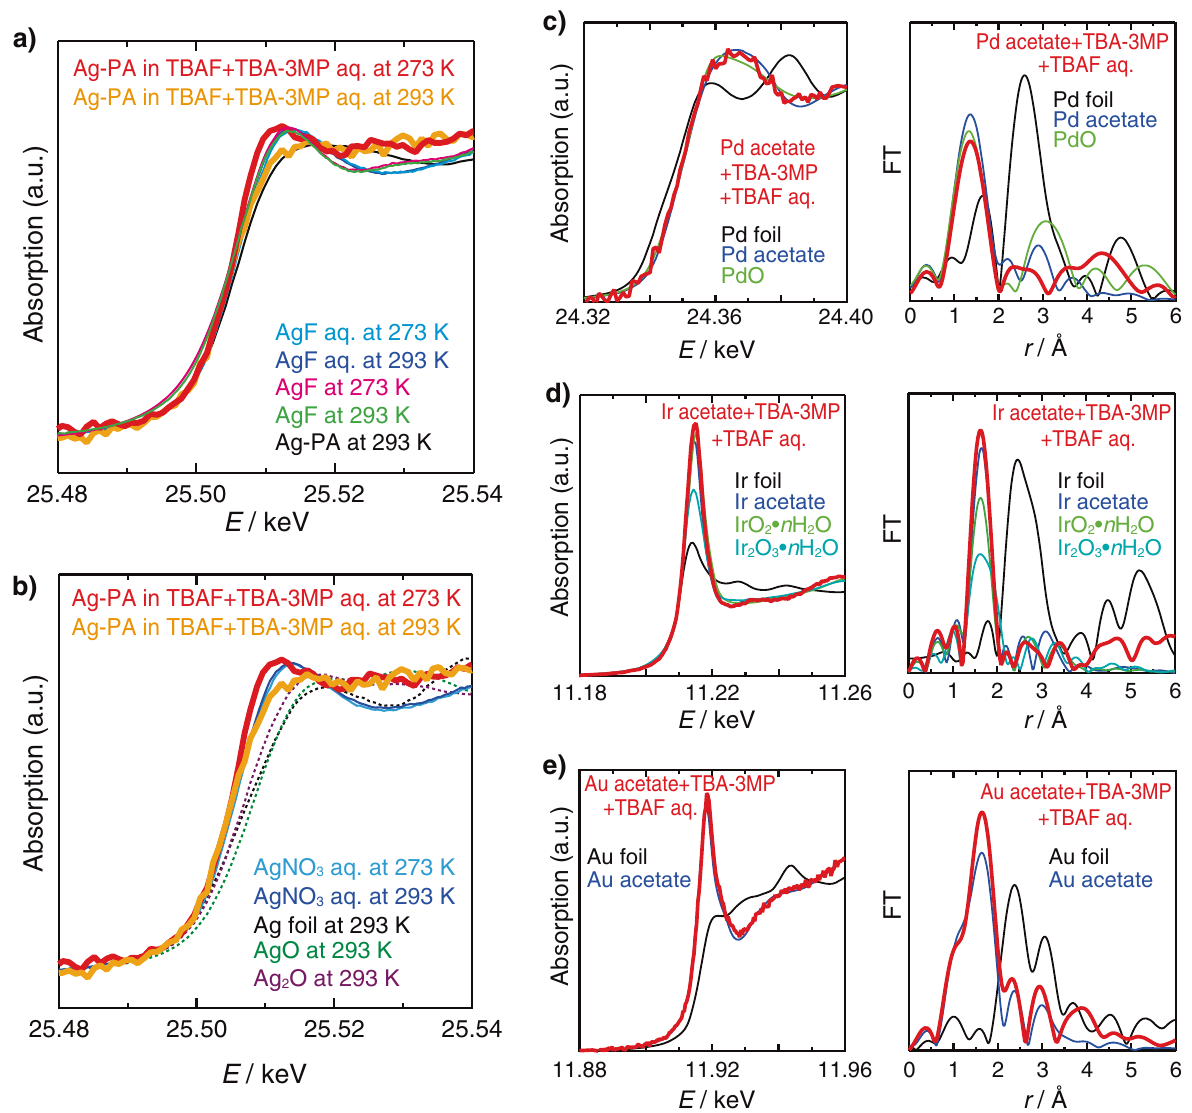
Fig. 4 XAS spectra. a Comparison of Ag K -edge XANES spectra of Ag-PA in TBAF + TBA-3MP aqueous solutions at 273 K and 293 K with AgF, AgF aqueous solution, and Ag-PA. XANES spectrum of Ag species in TBAF + TBA-3MP aqueous solutions at 293 K has relatively no features. At 273 K, it approaches that of AgF in the aqueous solution. b Comparison of Ag K -edge XANES spectra of Ag-PA in TBAF + TBA-3MP aqueous solutions at 273 K and 293 K with other possible Ag compounds. c Pd K -edge XANES and FT-EXAFS spectra at 293 K. d Ir L III -edge XANES and FT-EXAFS spectra at 293 K. e Au L III -edge XANES and FT-EXAFS spectra at 293